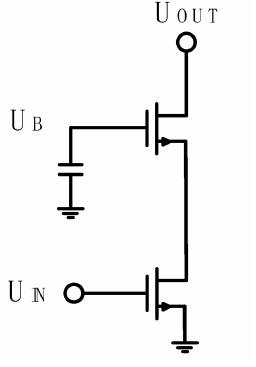
Figure 8. Cascode amplifier circuit schematic